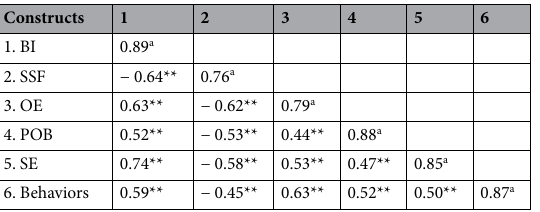
Table 5. Correlations with square roots of the AVE. a The square roots of AVE estimate. **Correlation is significant at the < 0.01 level.